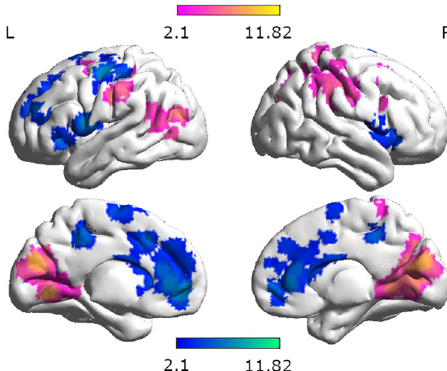
Fig. 3 Differential brain activation during navigation in women and men. Pink areas indicate stronger activation in women compared to men. Blue areas indicate stronger activation in men compared to women.